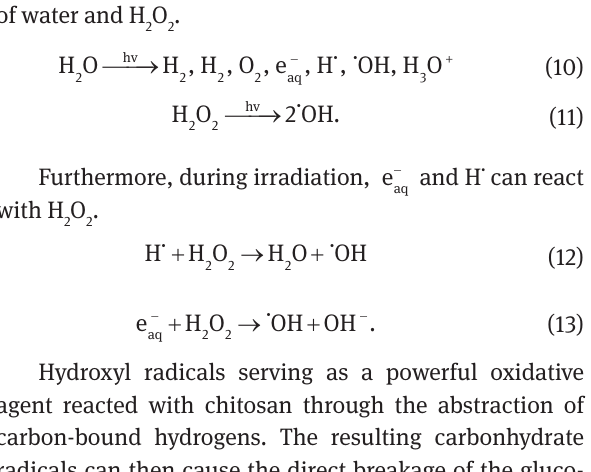
Figure 2: FT-IR spectra of the initial chitosan (CS in 2% H O (CS ), and chitosan irradiated at 4 (CS 2 2 02 16 (CS ), 20 (CS ), 24 kGy (CS 4 5